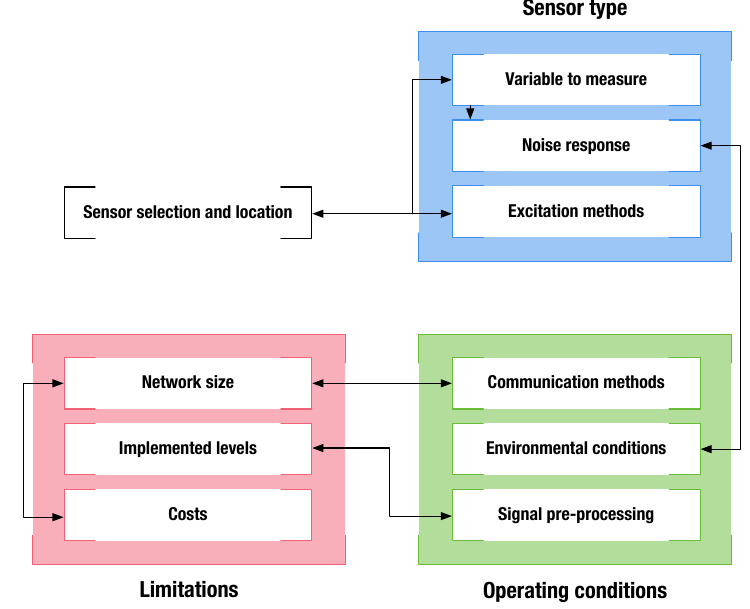
Figure 3. Sensor location and